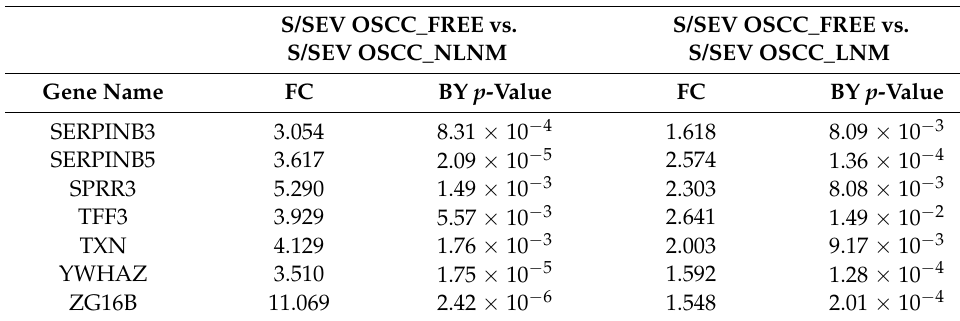
Table 5. Cont . PROTEINS UP-REPRESENTED in S/SEV OSCC_FREE vs.